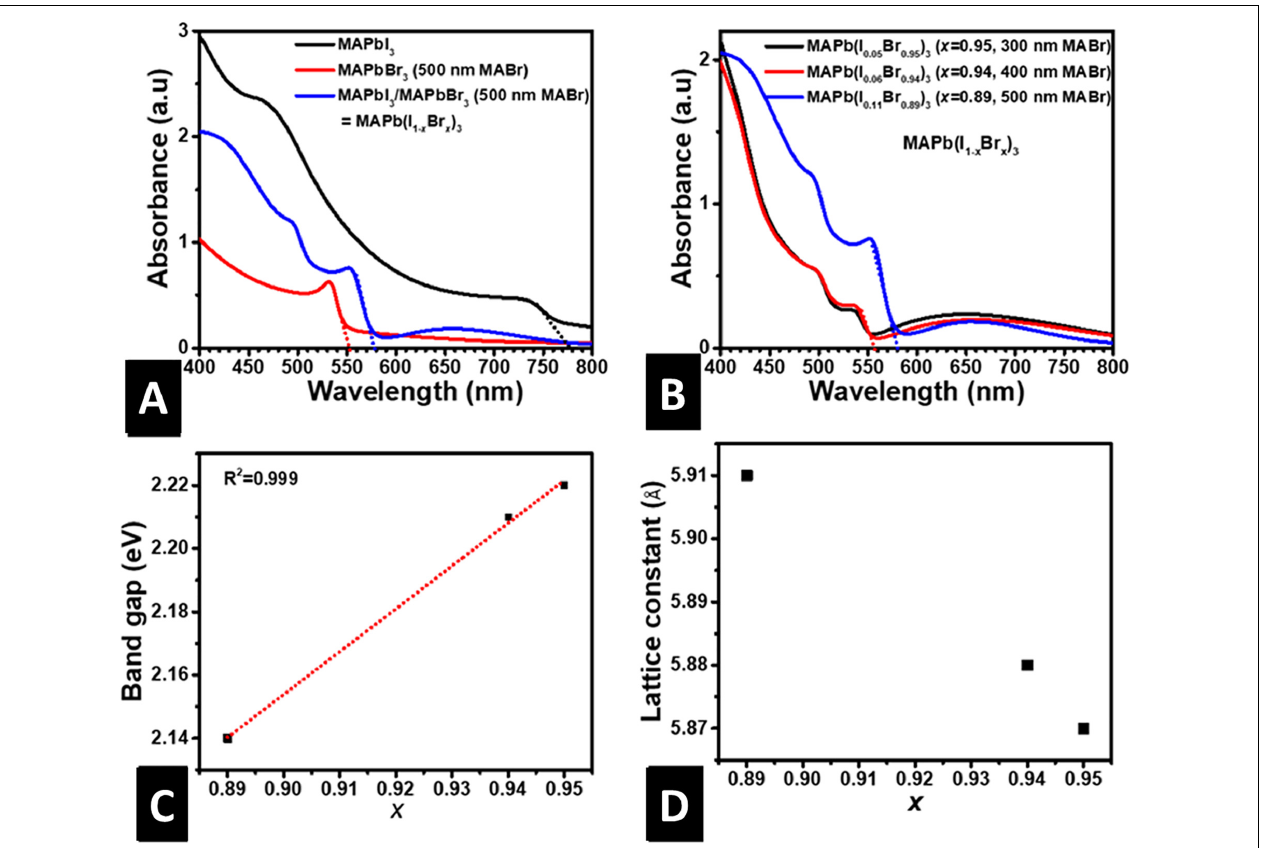
FIGURE 3 | (A) Absorbance vs. wavelength of MAPbI 3 , MAPbBr 3 and MAPb(I 0 . 11 Br 0 . 89 ) 3 , (B) Absorbance vs. wavelength of Pb(I 0 . 05 Br 0 . 95 ) 3 , MAPb(I 0 . 06 Br 0 . 94 ) 3 and MAPb(I 0 . 11 Br 0 . 89 ) 3 , (C) Bandgap of MAPb(I 1 − x Br x ) 3 vs. bromine mole ratio x , (D) Lattice constant of MAPb(I 1 − x Br x ) 3 vs. bromine mole ratio x